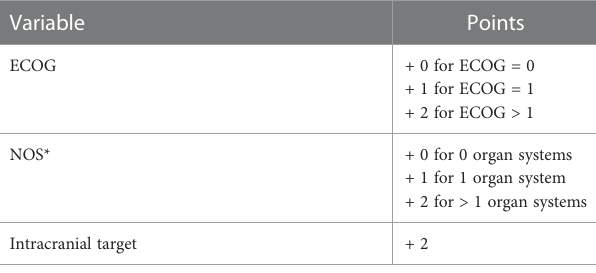
TABLE 3 The model components and their corresponding weights are tabulated. Variable